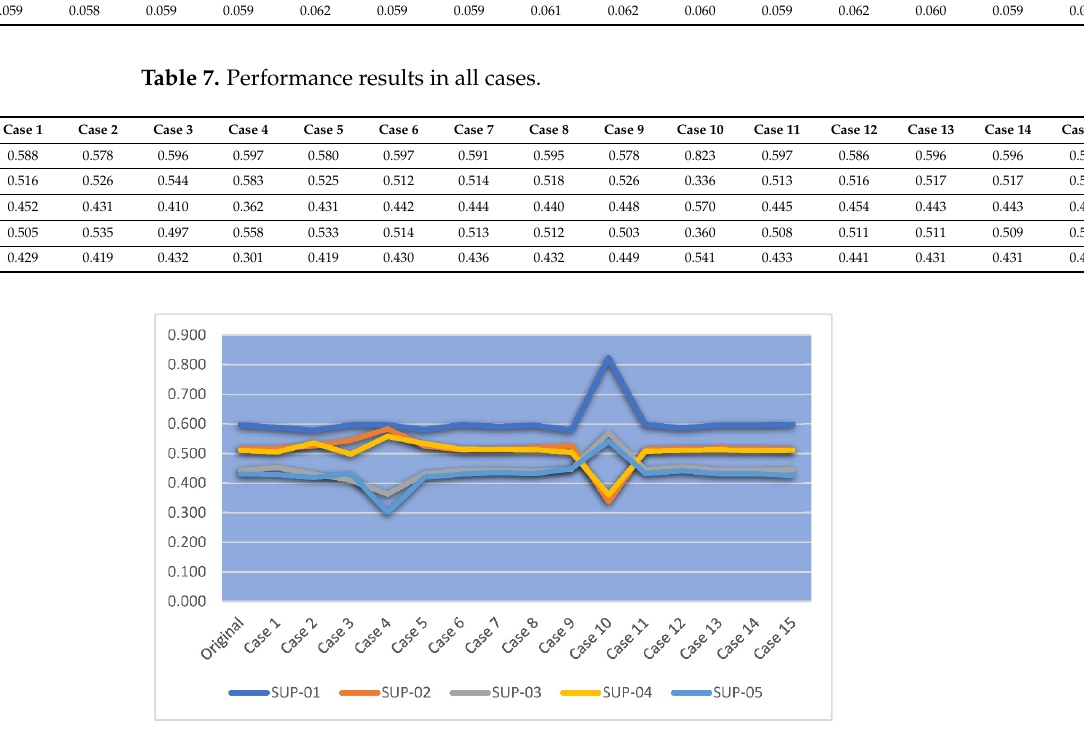
Figure 6. Ranking results in all cases. Table 7. Performance results in all cases.